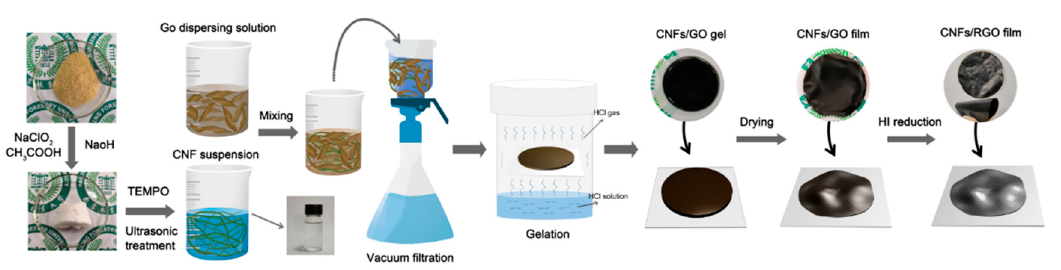
Figure 1. Schematic illustration of the fabrication process and structure of the cellulose nanofibril (CNF)/reduced graphene oxide (RGO) composite films.